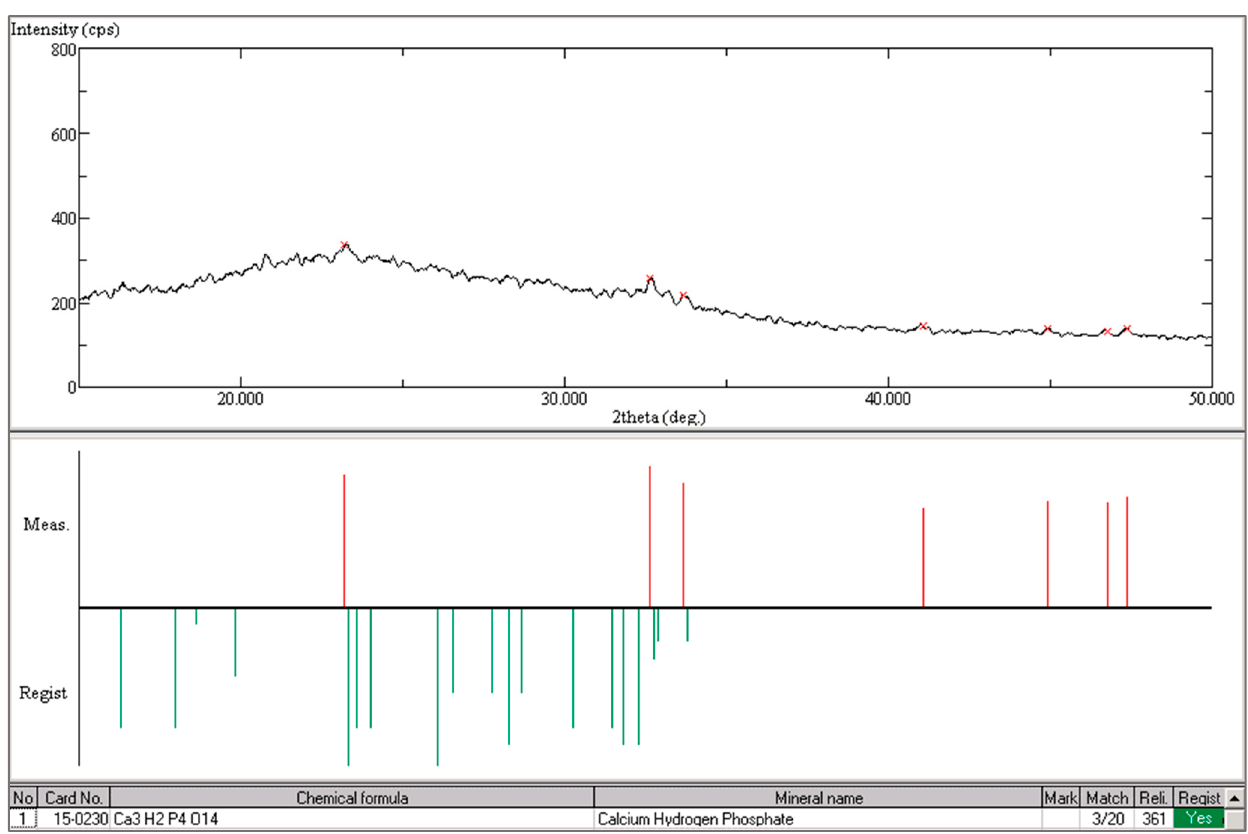
Figure 49. X-ray diffraction pattern of light blue tessera opacified with Ca-phosphate (KH_G10 light blue natron-based Egypt I glass tessera from Khirbet al-Mafjar, Palestine [23]).